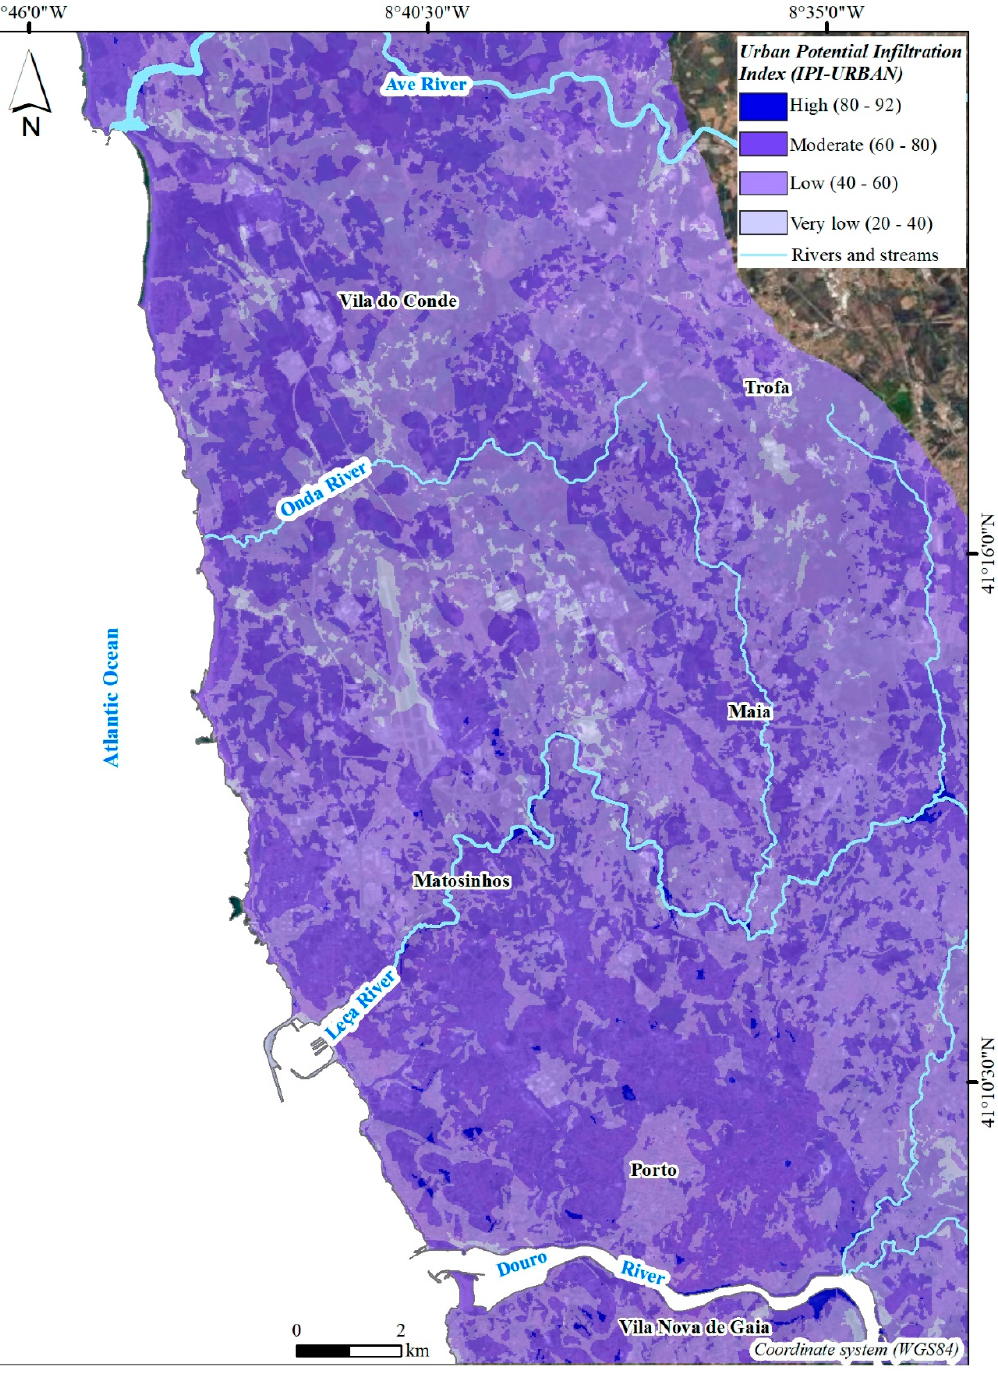
Figure 8. Urban infiltration potential index (IPI-Urban) in the Porto urban region (NW Portugal).